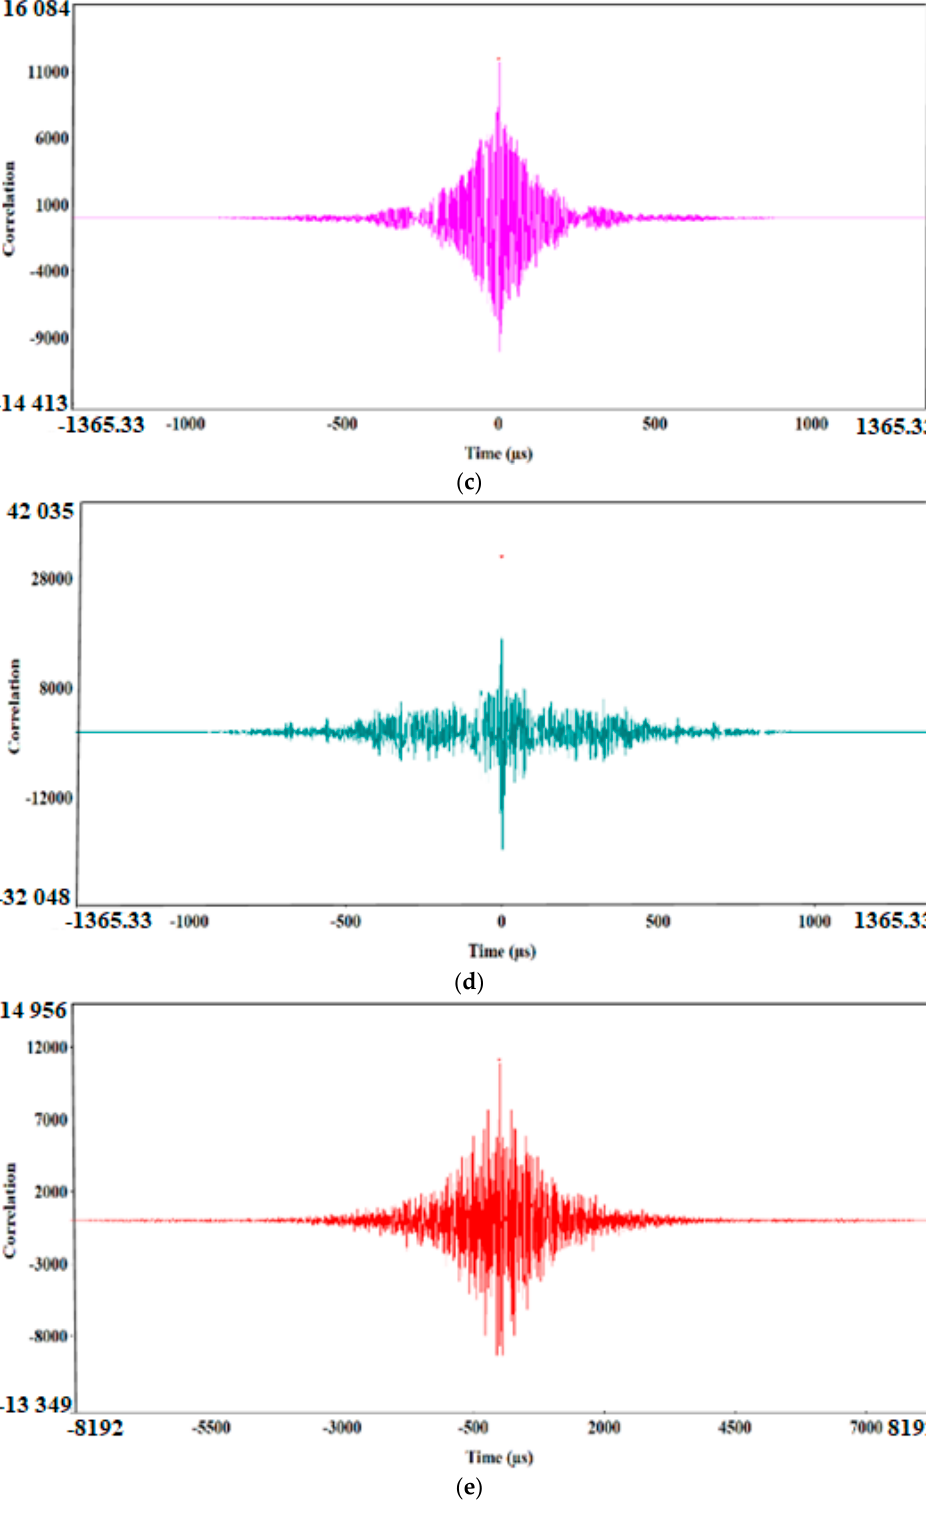
Figure 15. Waveform time domain (autocorrelation) chart for the individual classes of AE signals. ( a ) class 1; ( b ) class 2; ( c ) class 3; ( d ) class 4; ( e ) class 5.